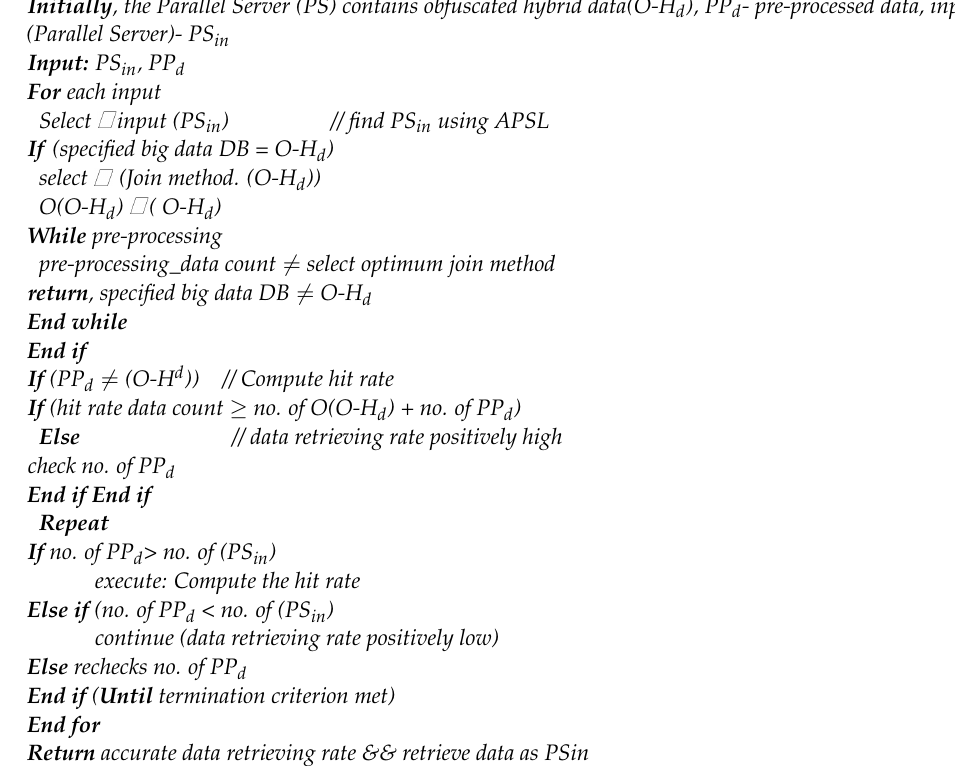
Algorithm 3: Algorithm for Data Retrieval Using